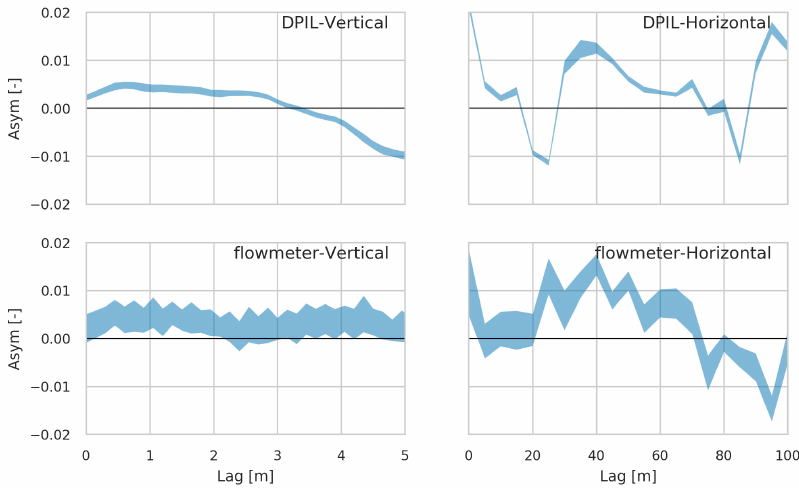
Figure 5. Value areas of the copula-based asymmetry (Asym) of bootstrapping tests with random selections of the 70% of the whole data set.